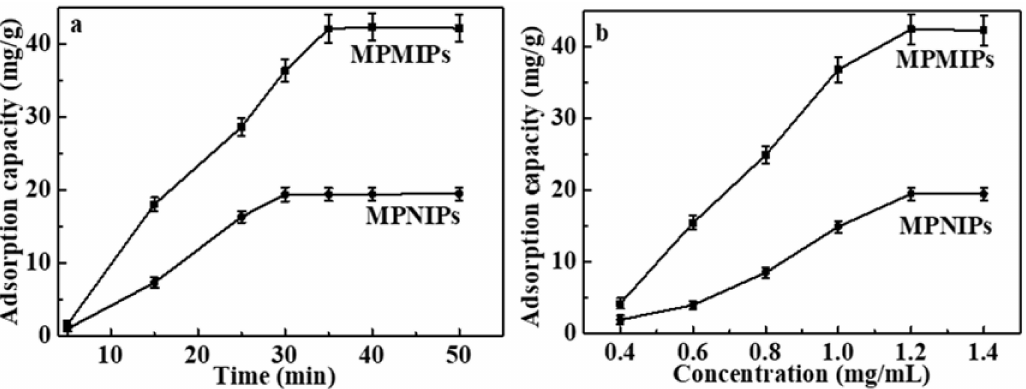
Figure 3. ( a ) Kinetic adsorption curves of MPMIPs/magnetic porous non-molecularly imprinted polymers (MPNIPs) by addition of 100.0 mg polymers in CGA solution (1.2 mg/mL) for 0–50 min; ( b ) Equilibrium adsorption curves of MPMIPs/MPNIPs by addition of 100.0 mg polymers in CGA solution (0.4–1.4 mg/mL) for 35 min ( n =